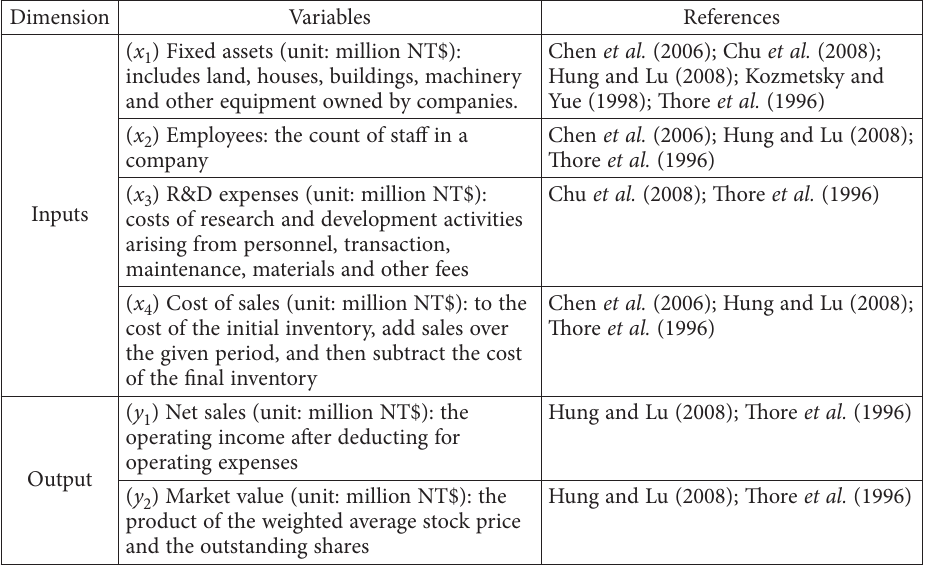
Table 1. Measures of inputs and